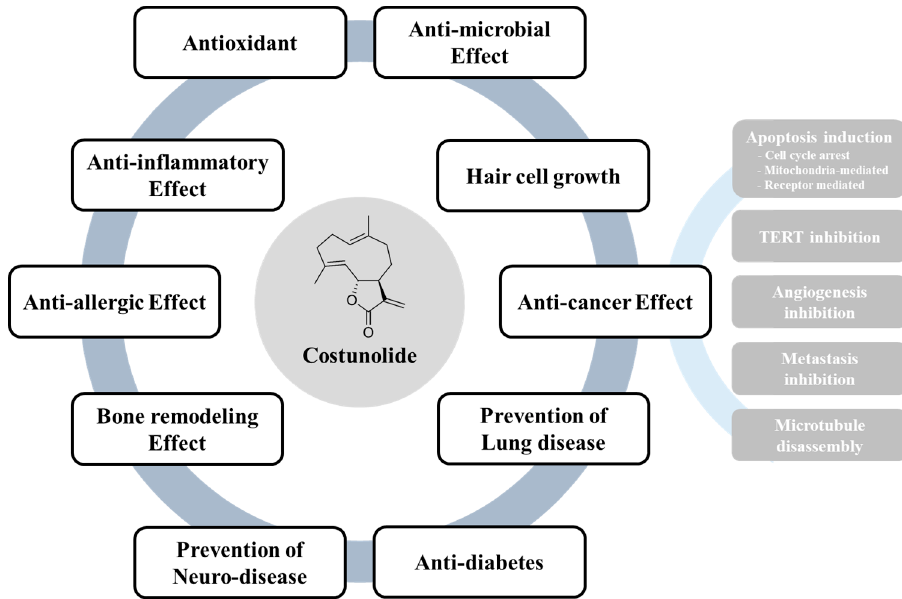
Figure 4. Bioactivities of costunolide. Costunolide could exert its therapeutic potential including antioxidant, anti-inflammatory effect, anti-allergic effect, bone remodeling effect, prevention of neurodegenerative disease, anti-microbial effect, inhibition of alopecia, prevention of lung disease and anti-diabetic effect. In particular, costunolide elicits anti-cancer activities partly through induction of apoptosis, Inhibition of cell proliferation, TERT, angiogenesis, metastasis and microtubule disassembly.